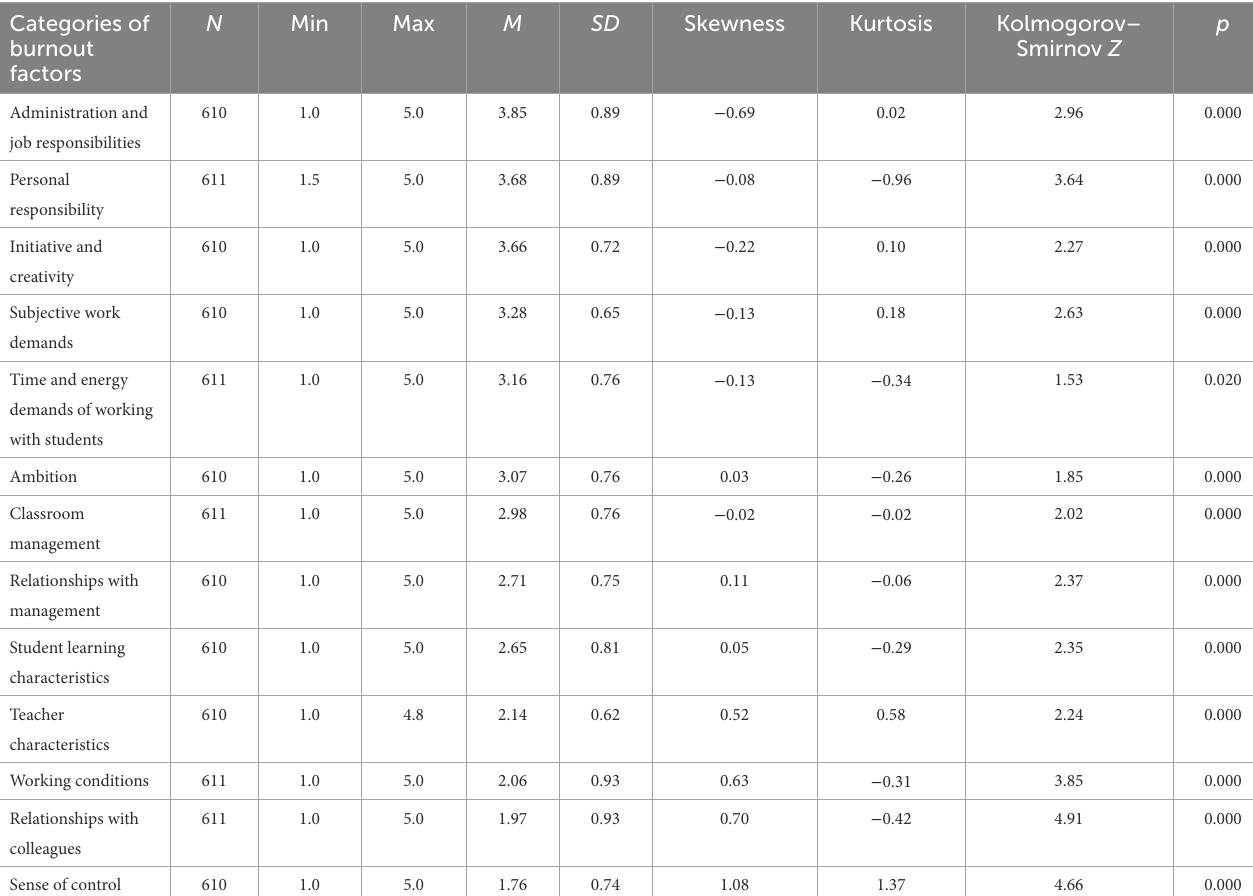
TABLE 9 Descriptive statistics of categories of predictors of burnout in